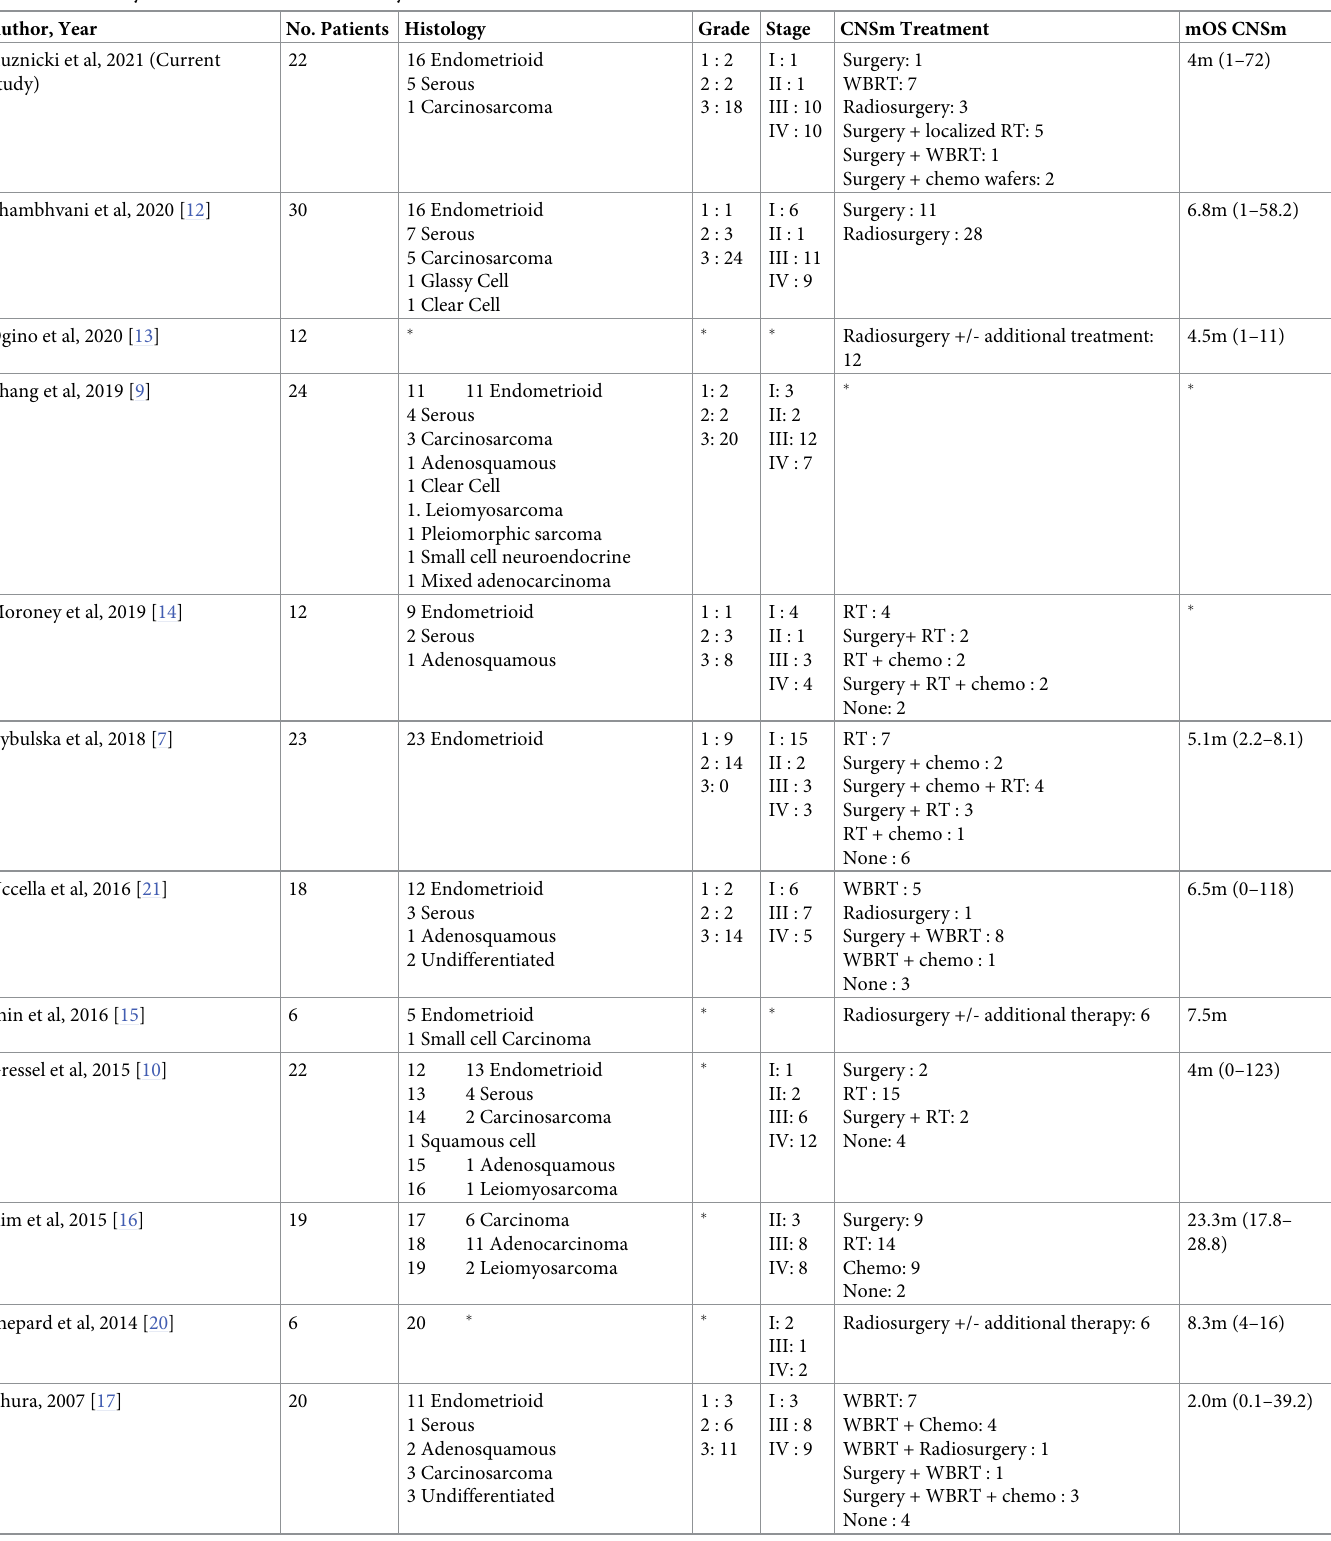
Table 4. Summary of studies on central nervous system metastasis in endometrial